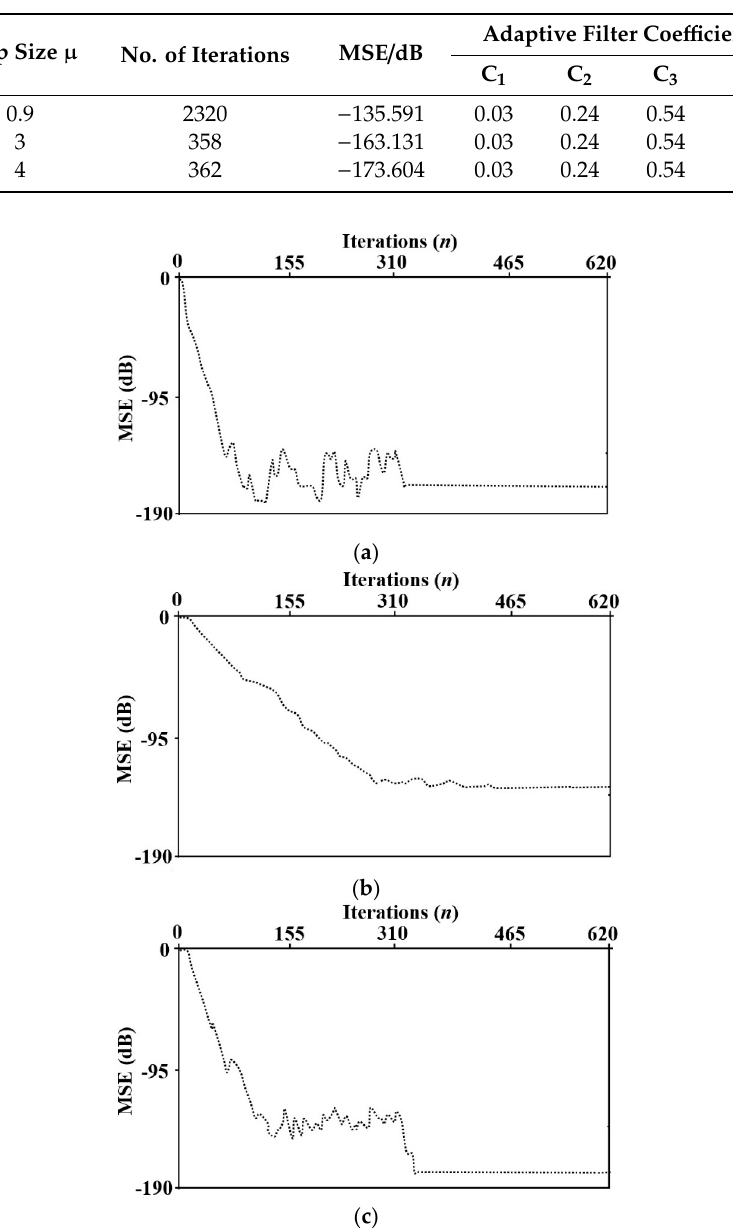
Figure 16. The learning curves for the case of the colored input signal, ( a ) 𝜇 = 3 , ( b ) 𝜇 = 0.9 , and ( c ) 𝜇 = 4